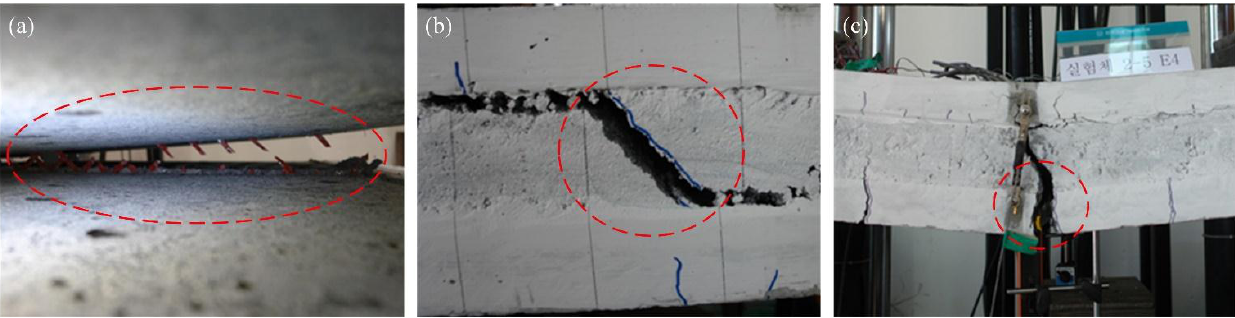
Figure 8. ( a ) Connecting element (bond, shear grid) failure of specimens with two or three GRFP shear grids; ( b ) shear failure of EPS foam in the positive loading test; ( c ) steel fracture of the concrete wythe in the EPS4_P